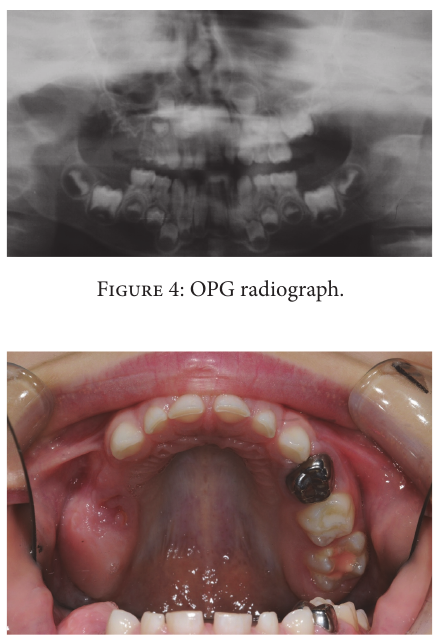
Figure 5: Upper arch, posttreatment.